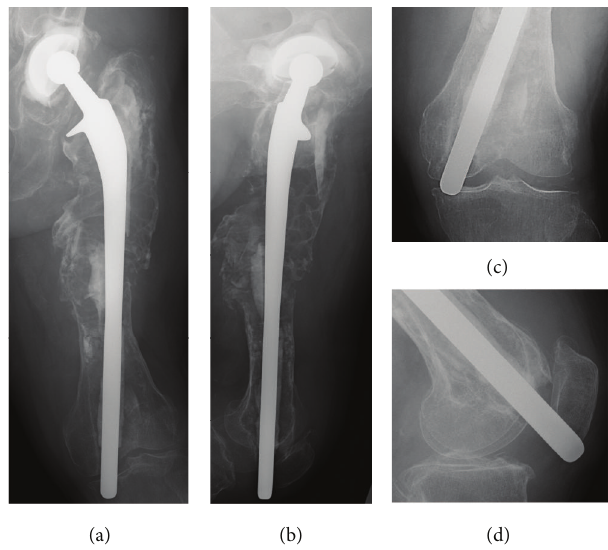
Figure 1: Radiographs of the left femur and knee at initial presen- tation. Anteroposterior (a) and lateral (b) views of the left femur 18 years after revision surgery show severe loosening of the acetabular cup and femoral stem. Radiographs of the left knee show the distal end of the stem had perforated the medial femoral condyle, reaching subcutaneous tissue through the knee joint (c), (d).